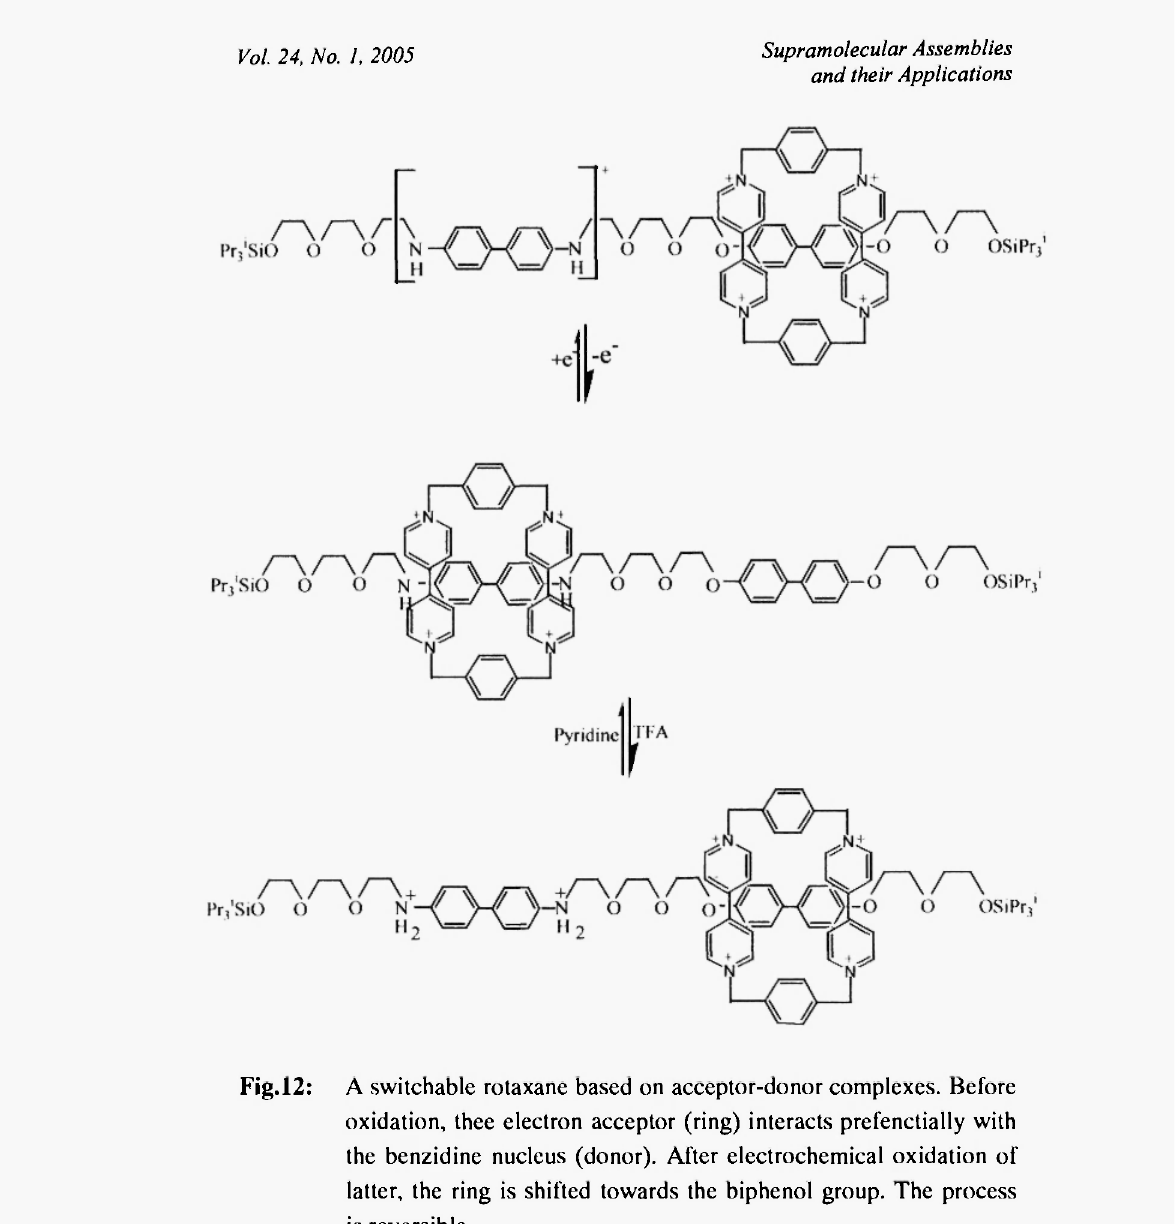
Fig.12: A switchable rotaxane based on acceptor-donor complexes. Before oxidation, thee electron acceptor (ring) interacts prefenctially with the benzidine nucleus (donor). After electrochemical oxidation of latter, the ring is shifted towards the biphenol group. The process is